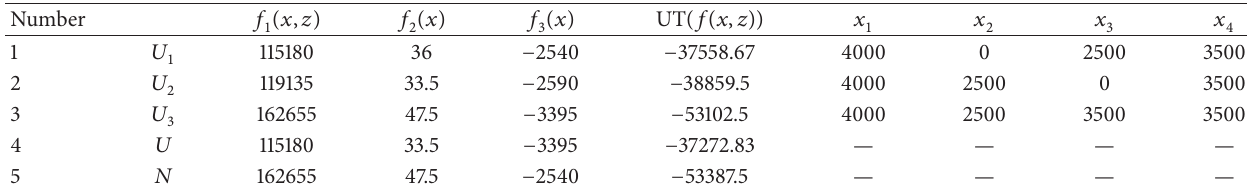
Table 1: The ideal and nadir points for Example